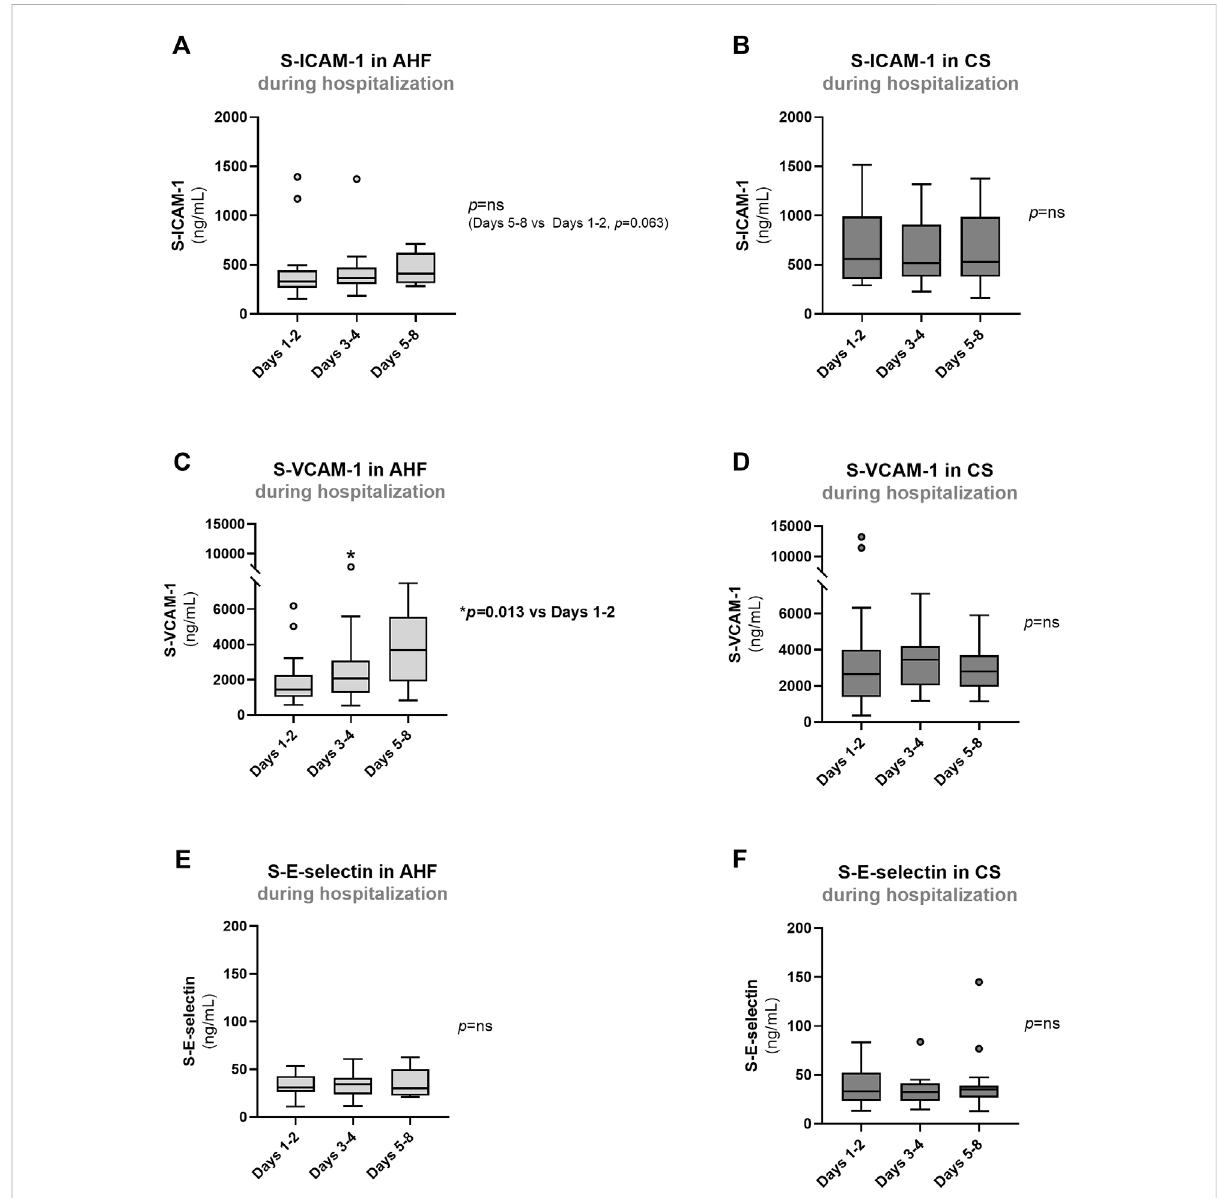
FIGURE 4 Evolution of biomarkers of endothelial dysfunction in AHF and CS patients during hospitalization: (A,B) S-ICAM-1; (C,D) S-VCAM-1); (E,F) S-E-Selectin. Results are presented in Box-and-Whiskers plot. AHF, acute heart failure; CS, cardiogenic shock; S-E-Selectin, serum E-Selectin; S-ICAM-1, serum intercellular adhesion molecule 1; S-VCAM-1, serum vascular cell adhesion molecule